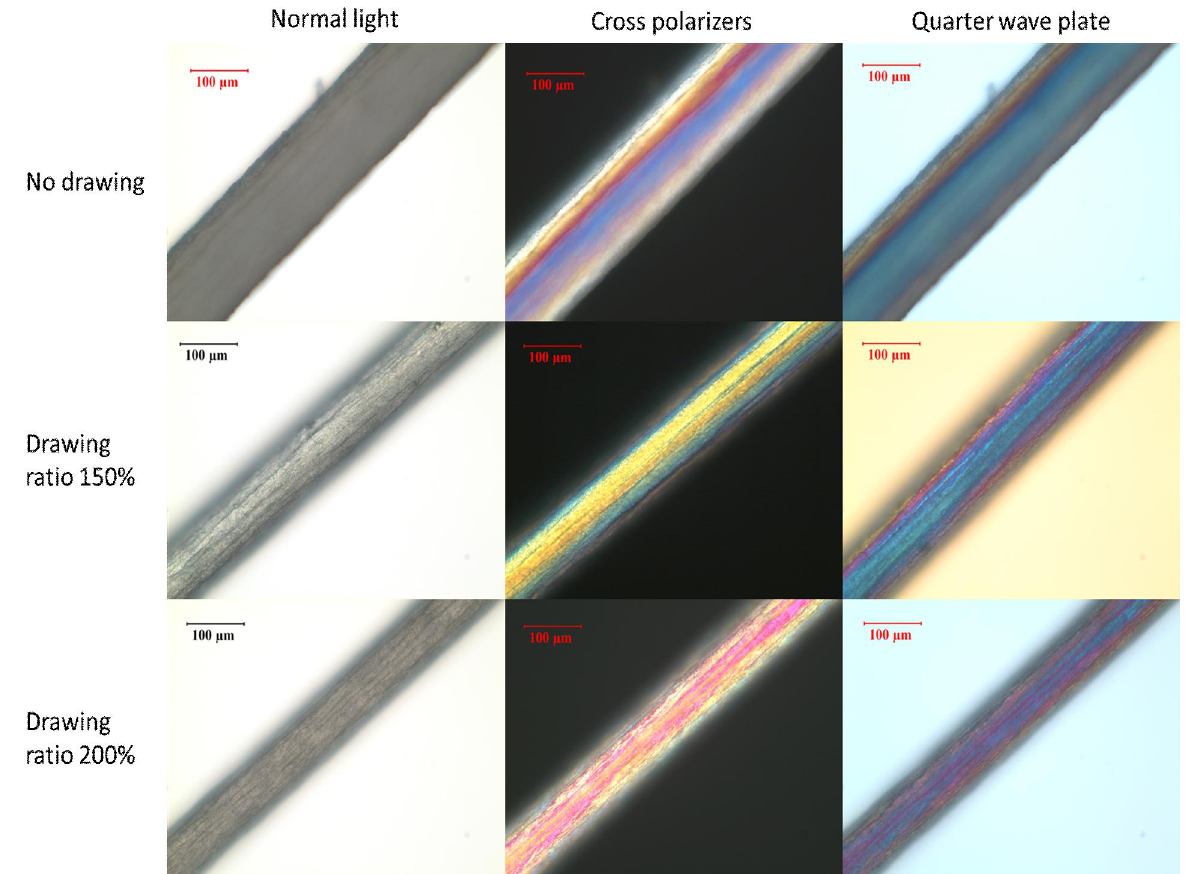
Figure 9. Micrographs of dried κ-carrageenan fibers with and without different ratios of